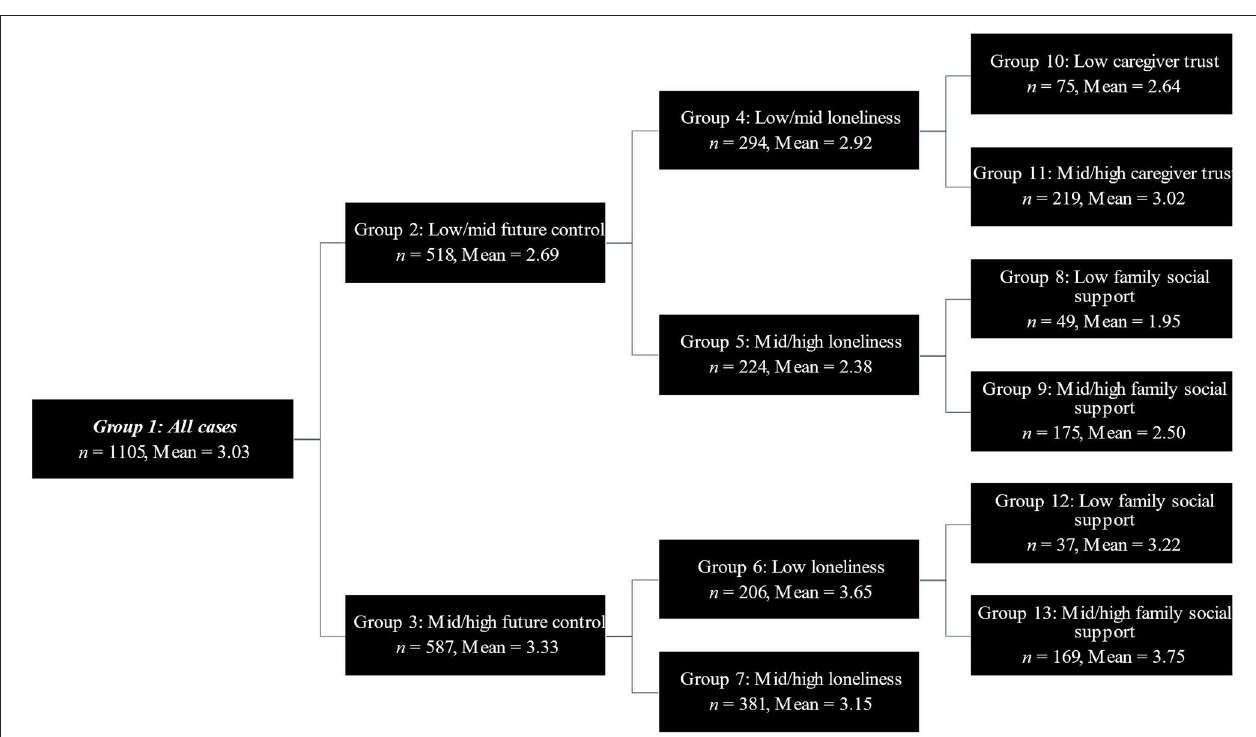
FIGURE 1 | SEARCH-ing for future e x pectation. The decision tree for the outcome future